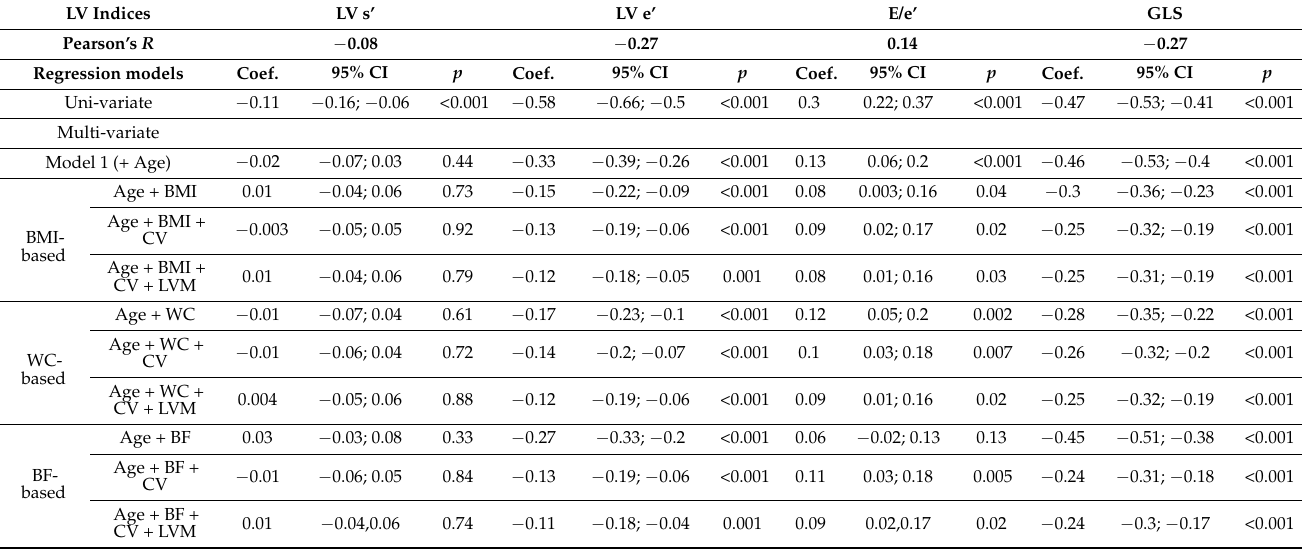
Table 3. Multivariate regression analysis of epicardial adipose tissue thickness (EAT) with ventricular structure and mechanics.